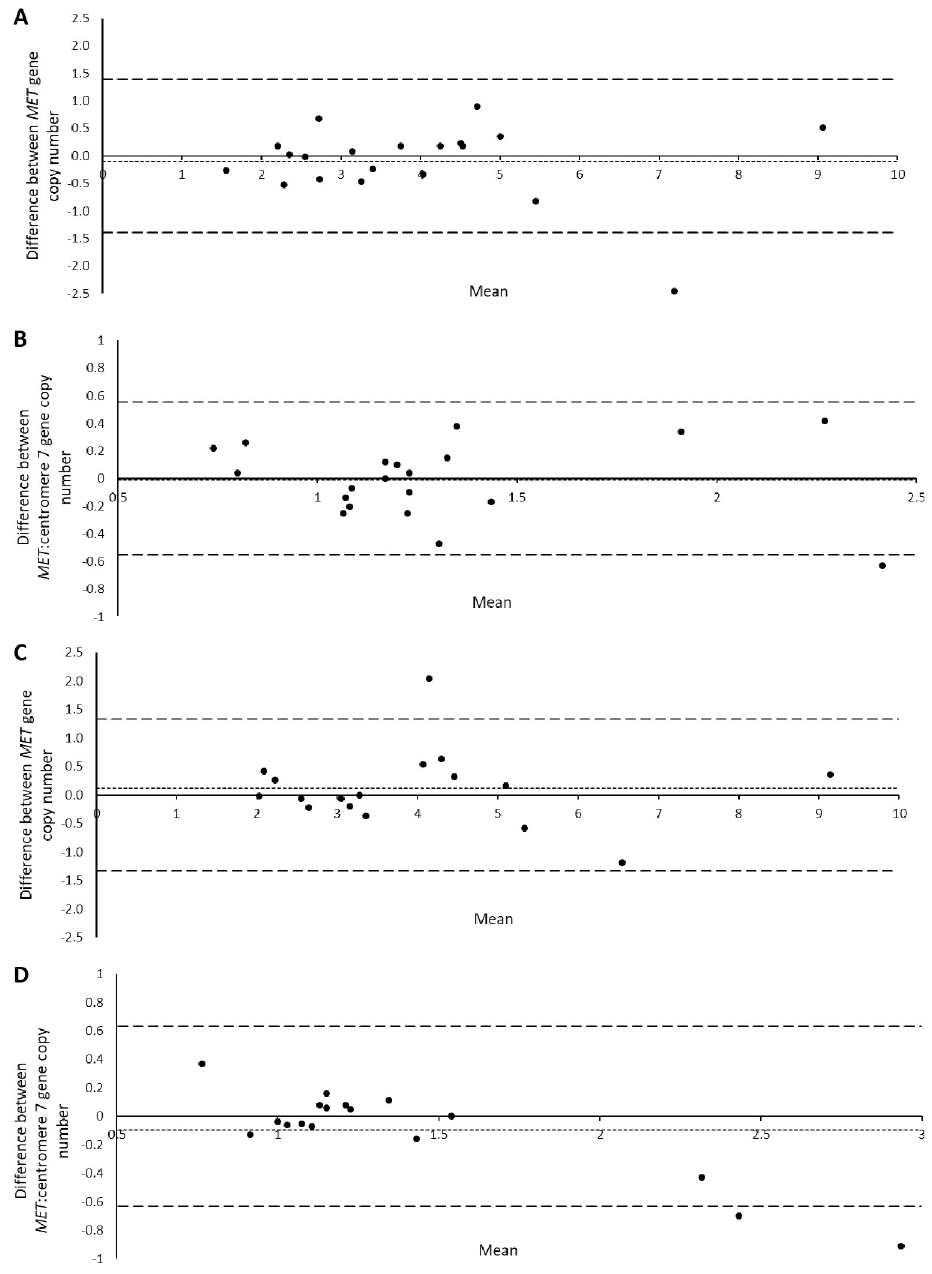
Fig 2. Bland altman plot of inter-assay agreement of MET gene copy number and MET : centromere 7 gene ratio between the standard Kreatech and fast Dako assay (A and B) and between the standard Kreatech assay and the fast Kreatech assay (C, D). Short dashed line represents the mean of the difference between assays, long dashed lines indicate ± 2 standard deviations ( ± 2